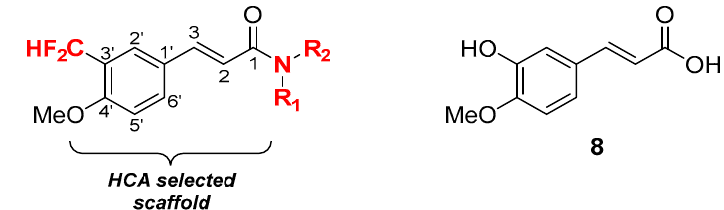
Figure 2. Proposed modifications (in red) to the coumaric acid ( 1 ) scaffold and analogy with isoferulic acid ( 8 ).